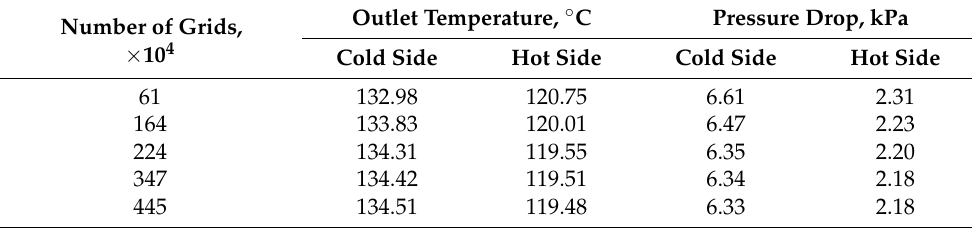
Figure 9. The model unit and boundary conditions. Five sets of grids are divided to verify the grid independence varying from 610,000 to 4,450,000. The outlet temperature and the pressure drop on both sides are compared in Table 5. When the number of grids exceeds 2,240,000, the parameters for comparison on both sides remain basically stable. The outlet temperature and the pressure drop fluctuate within 0.08% and 0.91%, respectively. It is preferred to select the 2,240,000 grids considering the cost of computing resources. Table 5. The grid independence